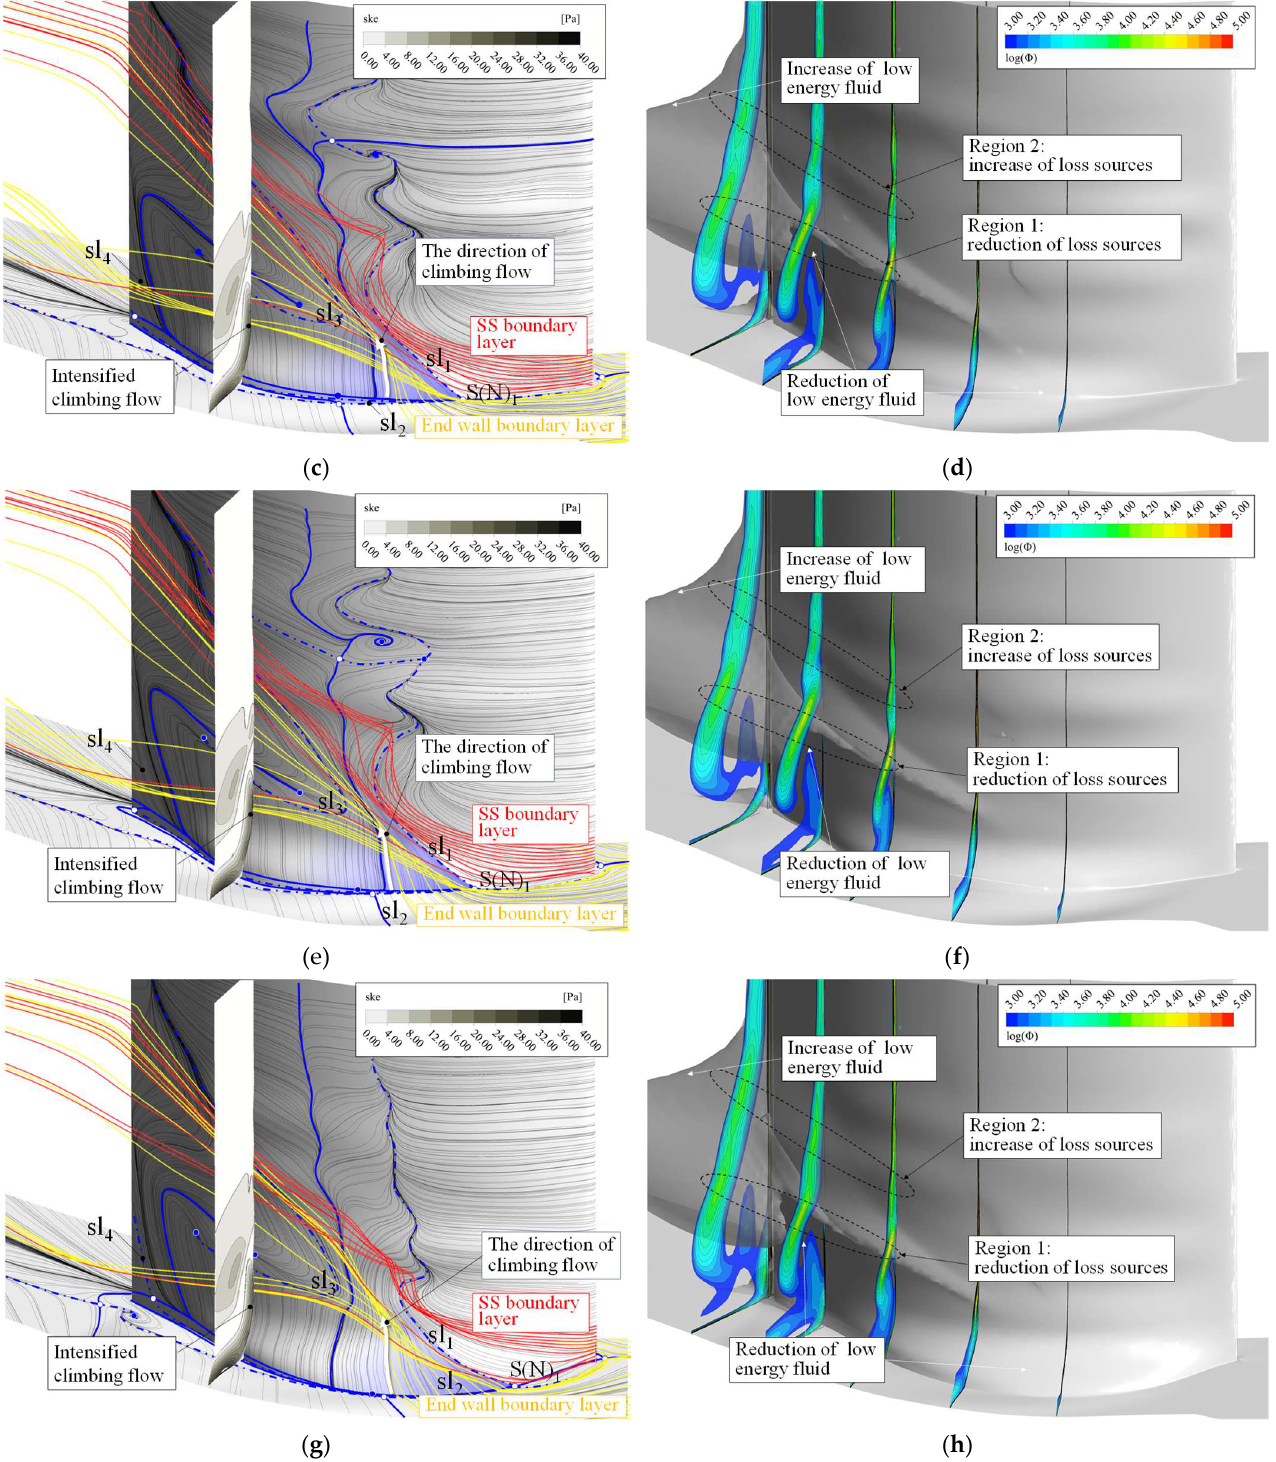
Figure 12. The flow field and distribution of loss source at the design point. ( a ) Flow field of the baseline case; ( b ) loss source of the baseline case; ( c ) flow field of case A; ( d ) loss source of case A; ( e ) flow field of case B; ( f ) loss source of case B; ( g ) flow field of case D; ( h ) loss of case D.